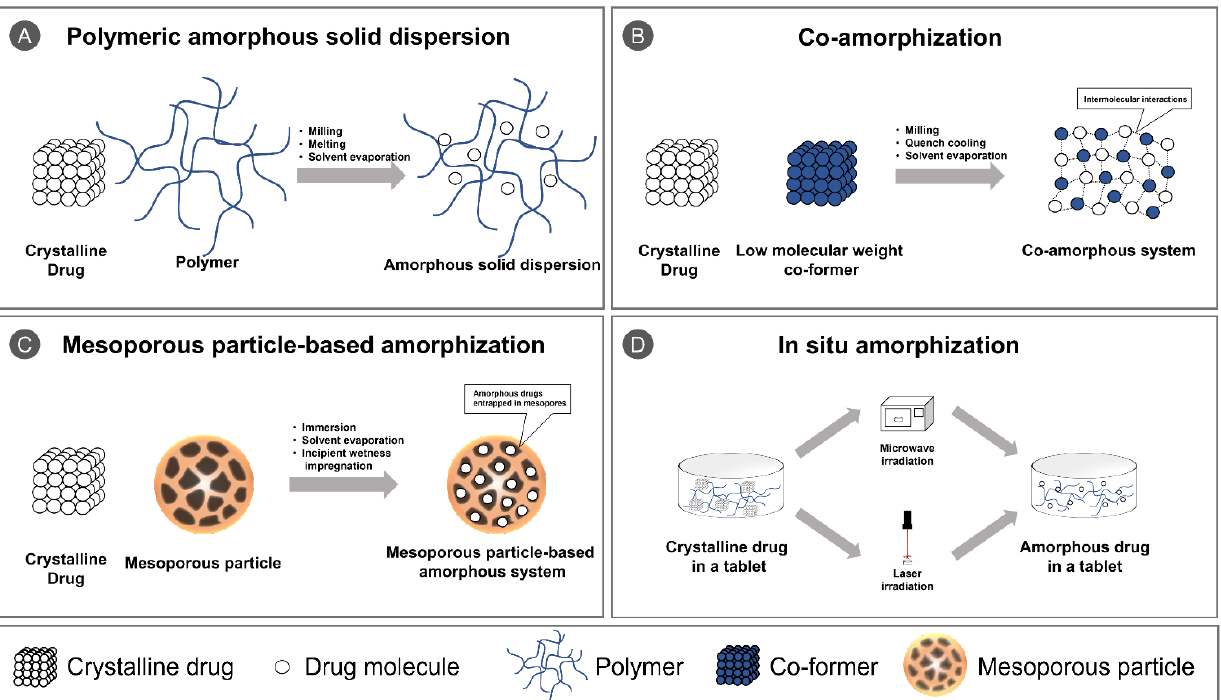
Figure 1. Schematic illustration of ( A ) polymeric amorphous solid dispersion; ( B ) co-amorphization; ( C ) mesoporous particle-based amorphization; and ( D ) in situ amorphization.